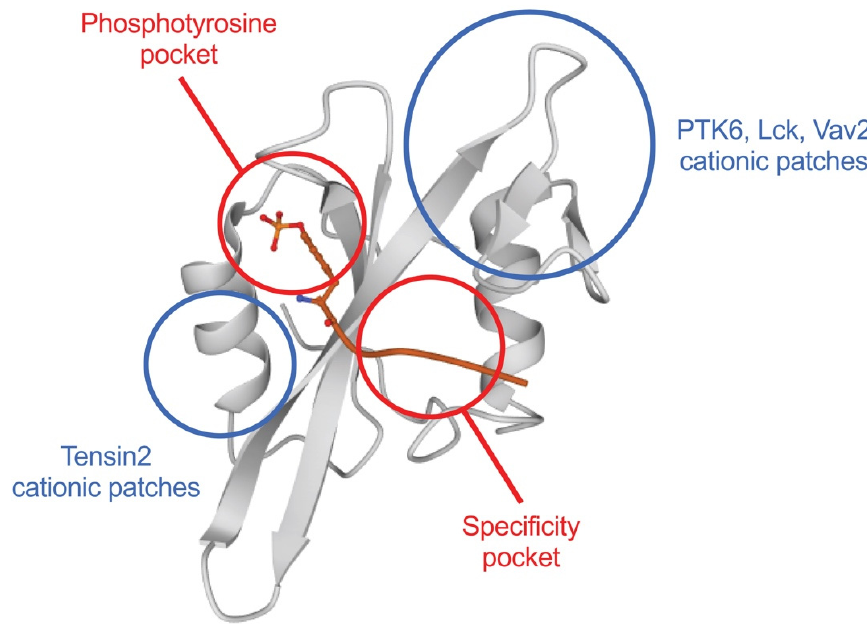
Figure 2. Visualization of the interacting zones of certain SH2 domains. The cationic patches respon- sible for lipid binding (blue) in different SH2 domains do not overlap with the pockets employed for specific phosphotyrosine recognition (red). For the generation of the schematic representation of the SH2 domain, we used the RCSB PDB database (www.rcsb.org accessed on 3 May